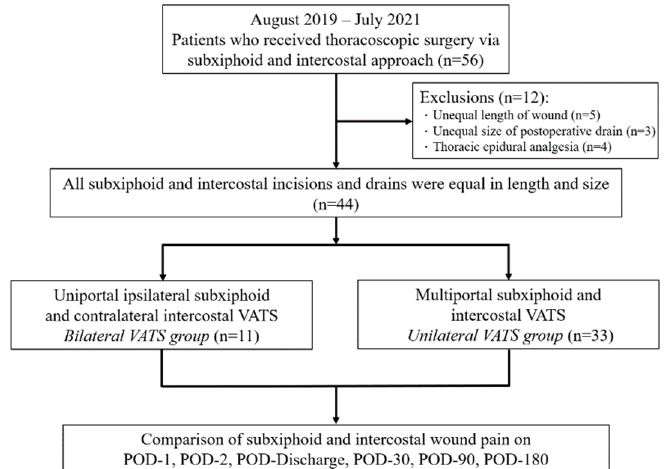
Figure 1. Flow diagram for patient recruitment. VATS, video-assisted thoracoscopic surgery; POD, postoperative day.